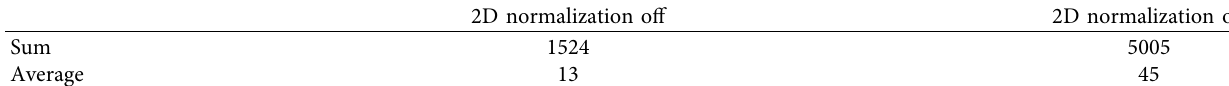
Table 3: The number of squares with 2D normalization on or off. 2D normalization off 2D normalization on